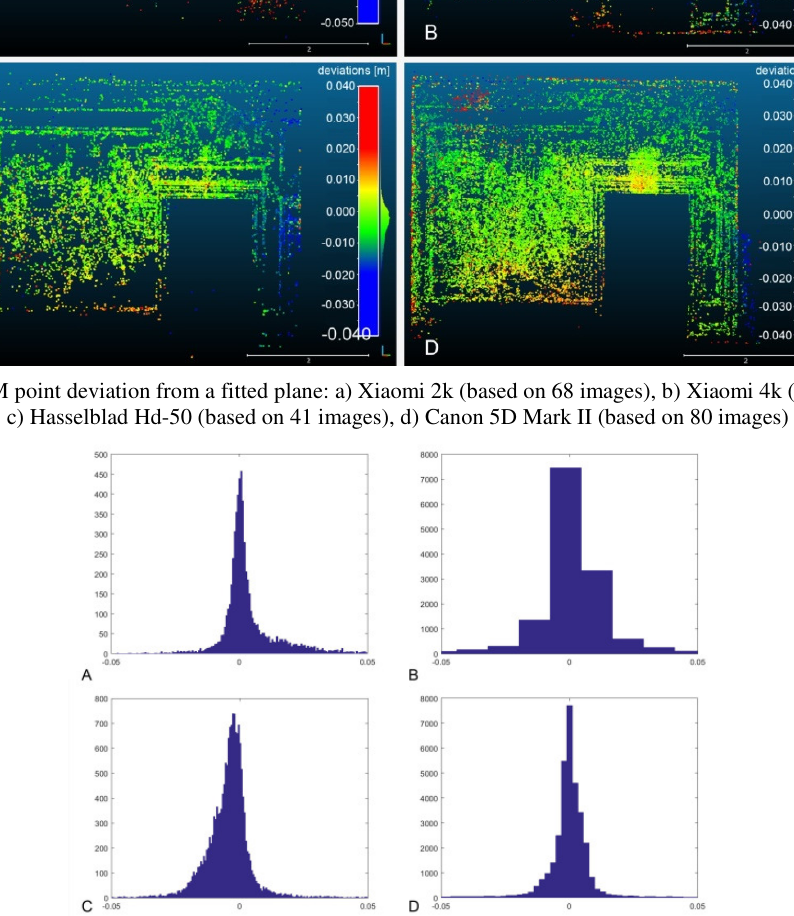
Figure 9. Histogram of SFM point deviations from a plane a) Xiaomi Yi 2k, b) Xiaomi Yi 4k, c) Hasselblad Hd-50, d) Canon 5D Mark